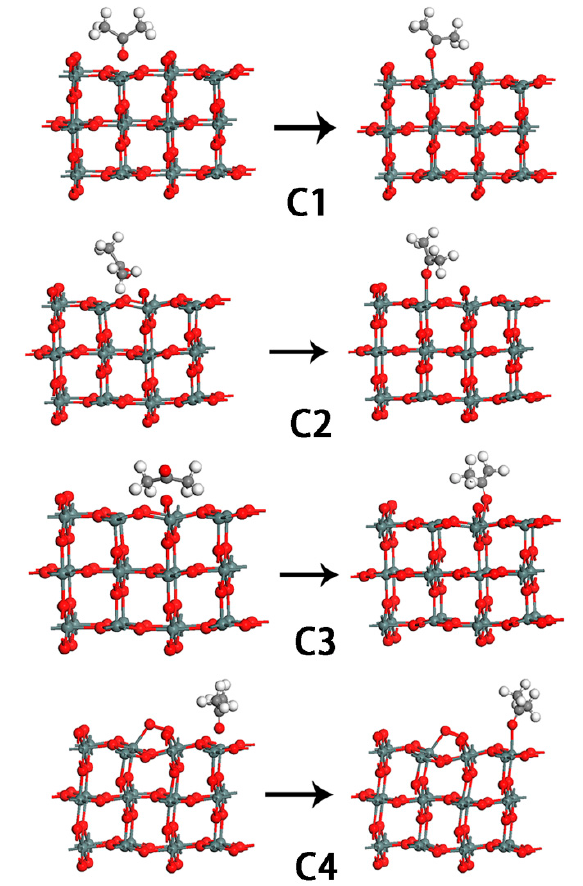
Figure 12. The four different adsorption configurations of acetone molecule on 2 × 2 SnO 2 (110) surface. C1: on stoichiometric SnO 2 surface; C2, C3: on defective SnO 2 surface; C4: on O 2 pre-adsorbed SnO 2 surface.